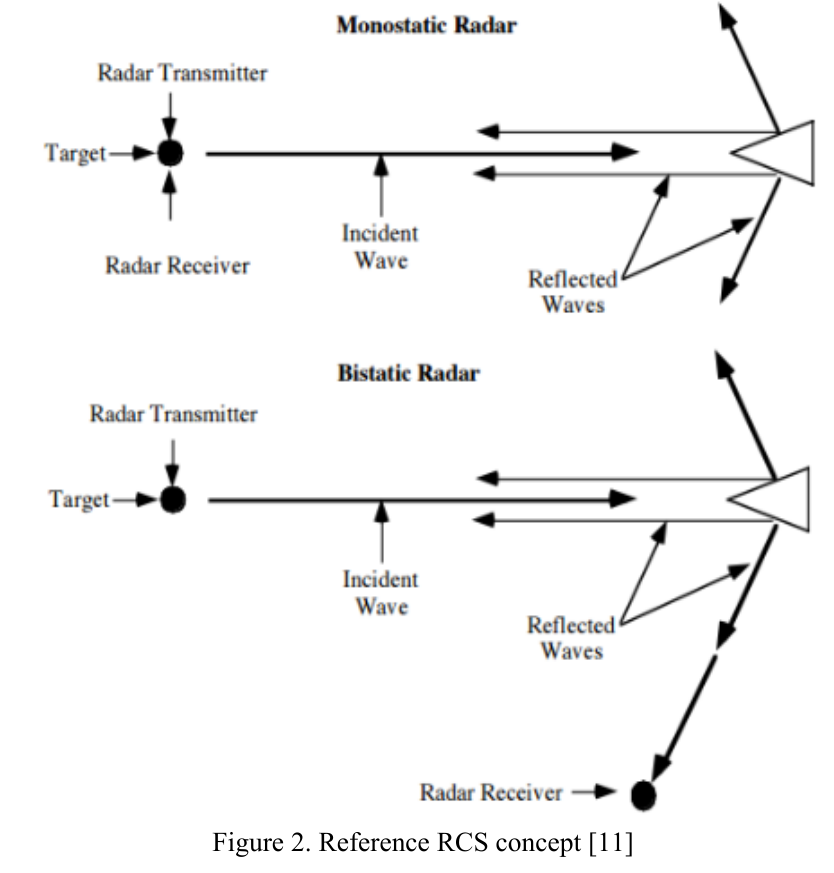
Figure 2. Reference RCS concept